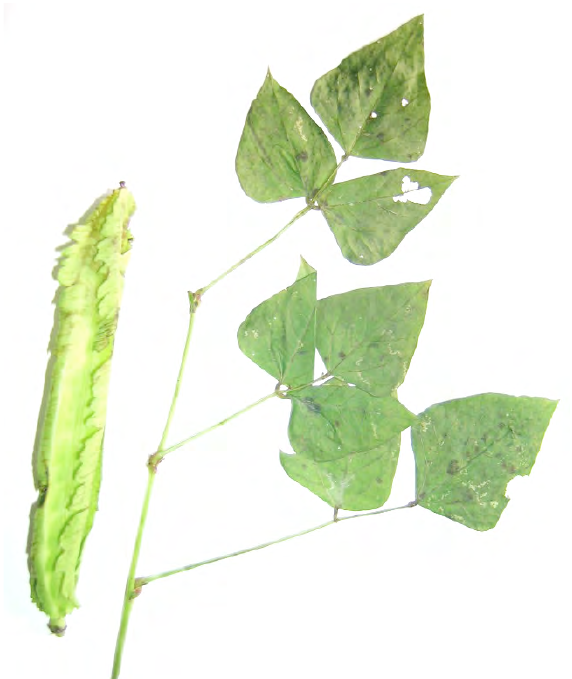
Image.9. Meliola psophocarpi -Infected leaves and